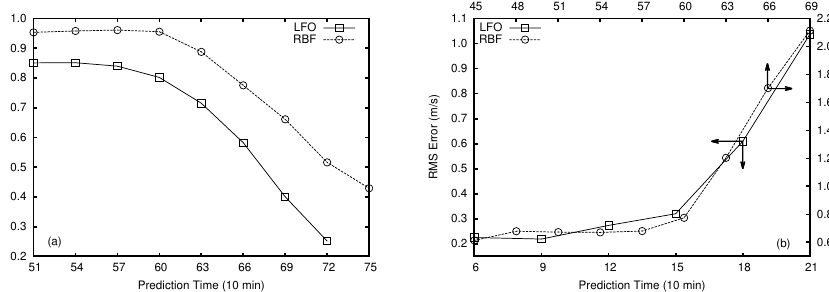
Figure 9. (a) The exponential decay of the correlation coefficient between the predicted and actual for every three prediction time steps. (b) The exponential growth RMSE prediction for every three prediction time steps. The arrows show axes for the respective symbols of data points.